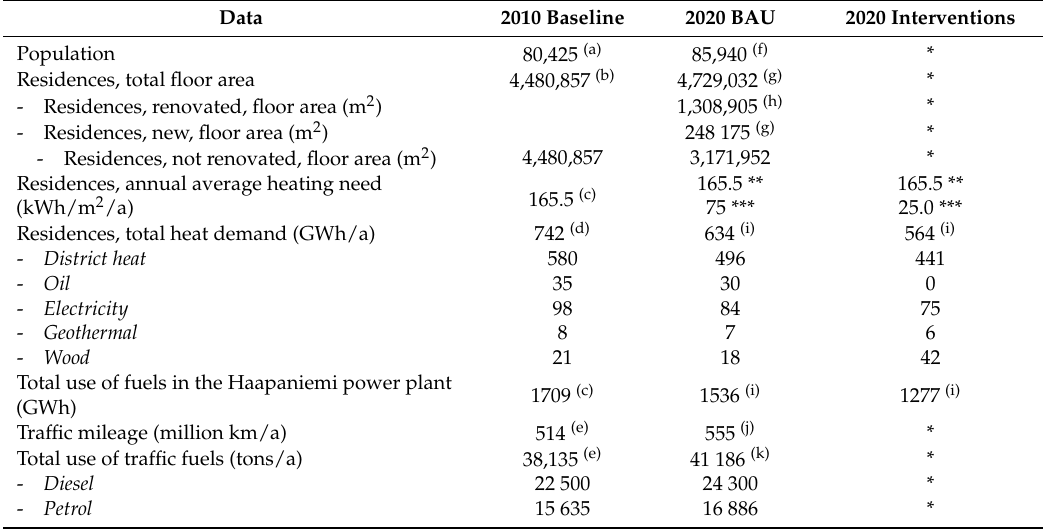
Table 2. Input data in each